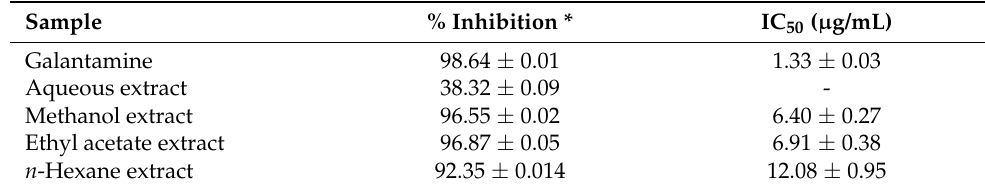
Table 4. The activity of Cassia timoriensis against acetylcholinesterase enzymes.